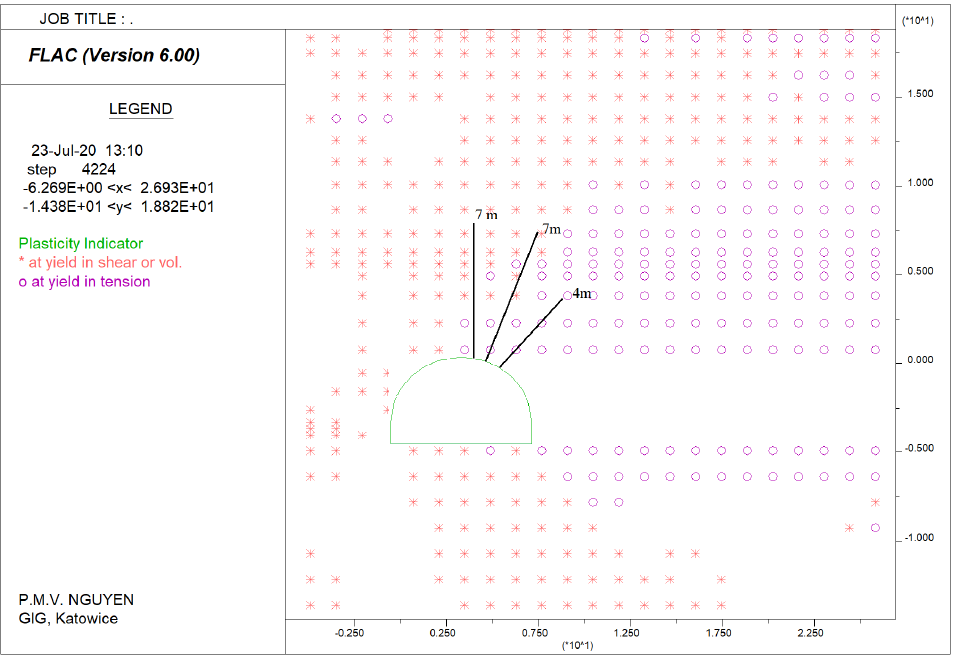
Figure 16. Caved zone above the longwall working after 1000 calculation steps.